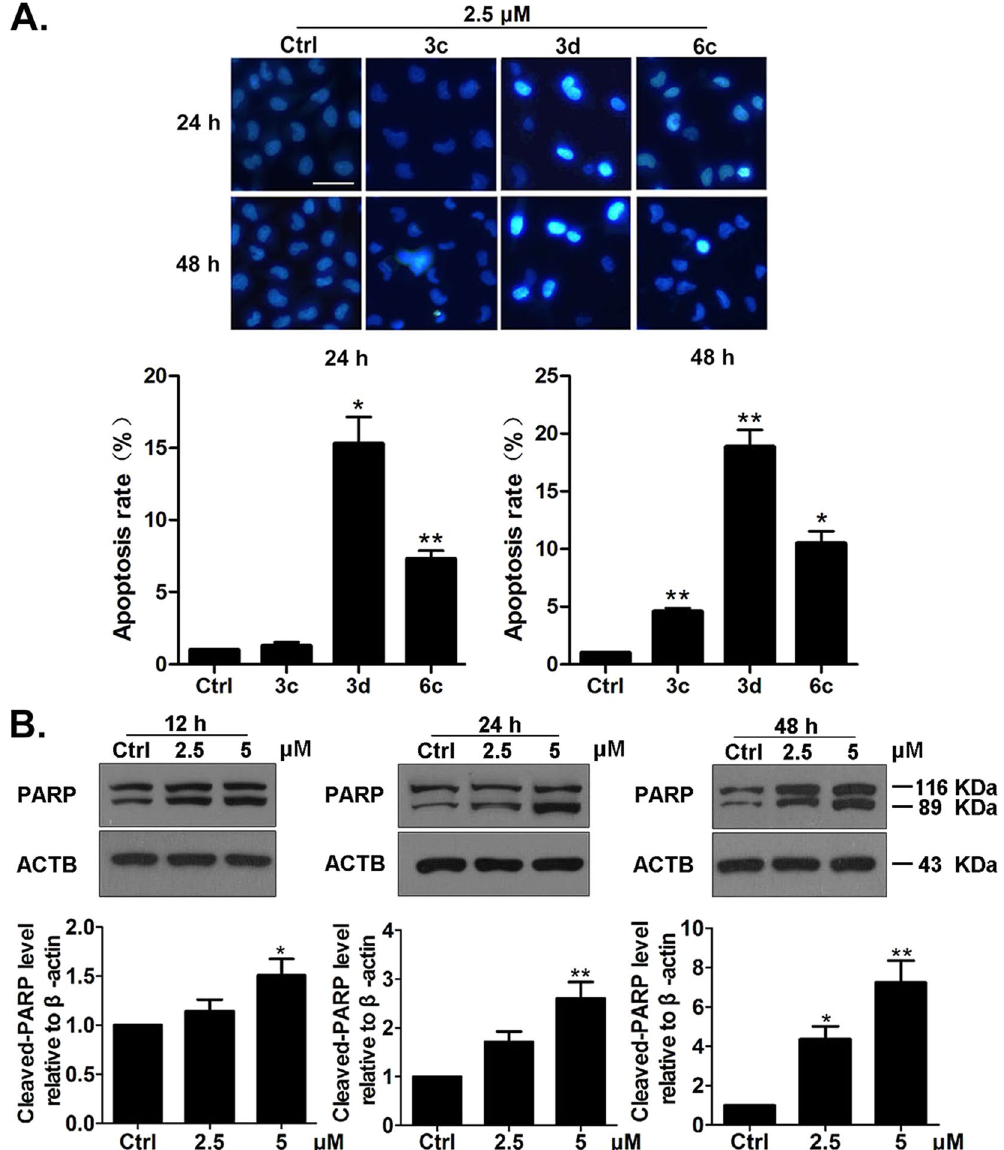
Figure 3. Compounds 3c, 3d and 6c induce A549 lung cancer cell apoptosis. Hoechst 33258 staining was conducted after treating the cells with the compounds (3c, 3d and 6c) at 2.5 μ M for 24 h and 48 h (magnification 200 × ). Fluorescent image of A549 lung cancer cells stained by Hoechst 33258 ( A ). Scale bar: 20 μ m. A549 cells were treated with compound 3d at 2.5 μ M and 5 μ M for 12 h, 24 h or 48 h. Western blot analysis ( B ). The relative levels of cleaved-PARP were normalized by the level of β -actin, and represented as percent of control. The control group (Ctrl) was treated with 0.1% DMSO (V/V). Results are mean ± SEM ( * p < 0.05, ** p < 0.01 vs control. N =